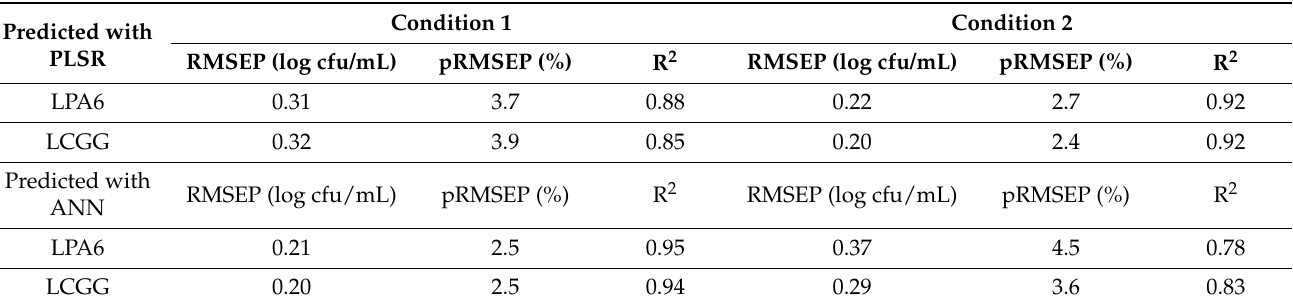
Table 1. The RMSEP, pRMSEP, and R 2 values for the prediction of LPA6 and LCGG cell growth using PLSR and ANN under two different fermentation